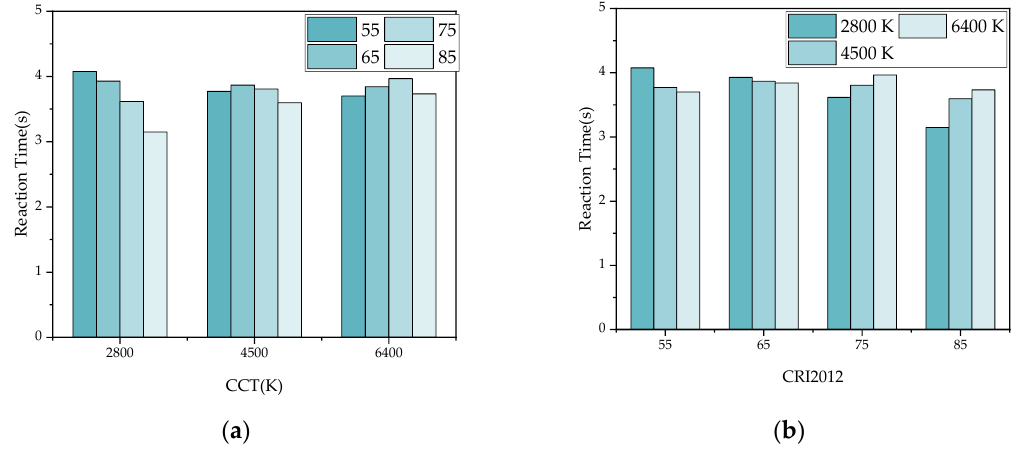
Figure 17. The average reaction time under 12 lighting conditions when HP-CCT is 5700K. ( a ) Take the CCT as the horizontal axis. ( b ) Take the CRI2012 as the horizontal axis